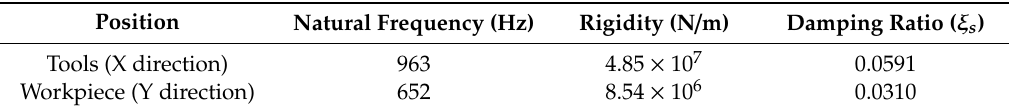
Table 1. The initial first-order modal